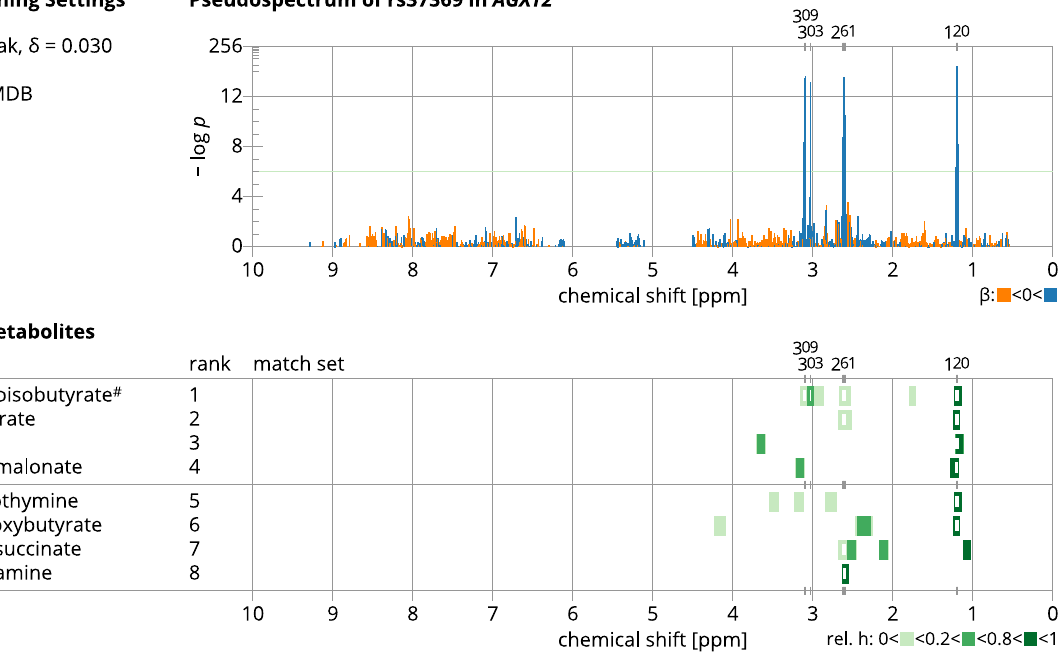
Fig 2. Metabomatching results figure. The metabomatching results figure, shown here for the same AGXT2 pseudospectrum as in Fig 1. The figure shows the metabomatching settings used, the pseudospectrum with features color-coded by effect size, and, for the eight highest ranked candidate metabolites, the score, name, and reference NMR spectrum with match sets color-codedaccordingto the height of the NMR spectrum peak they derive from.